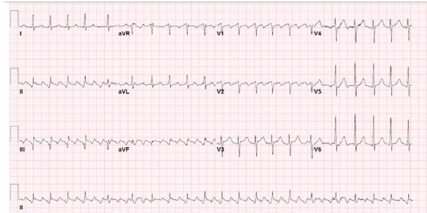
Figure 1: EKG showing typical atrial flutter with variable AV block.